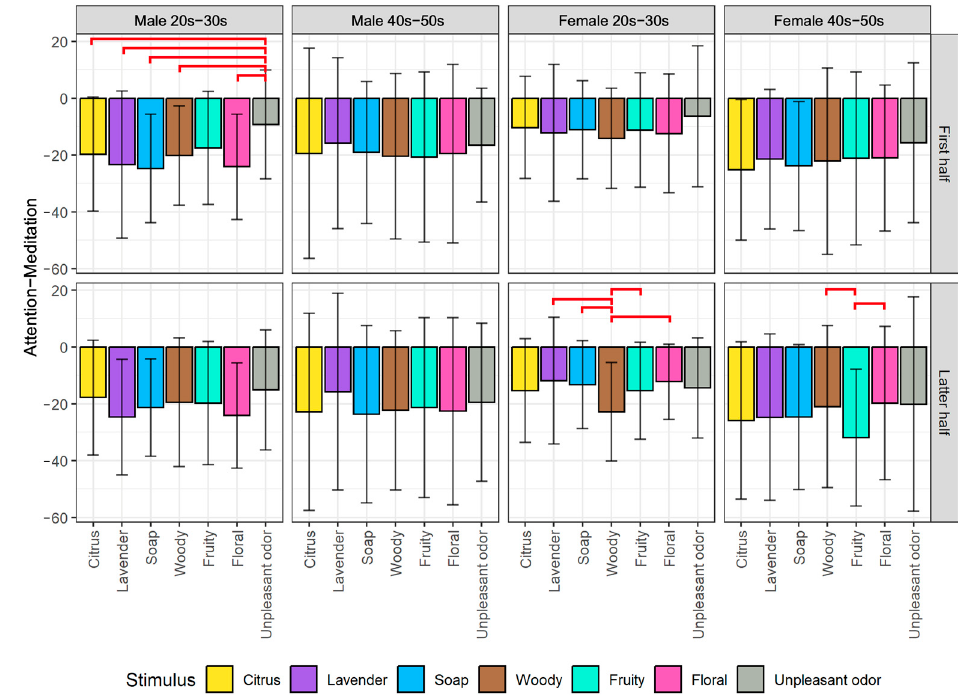
Figure 5. Comparison of changes in Attention − Meditation among stimuli by gender and generation groups divided into the first half (top) and latter half (bottom) of stimulus exposure time. The red lines indicate significant differences between pairs of stimuli.